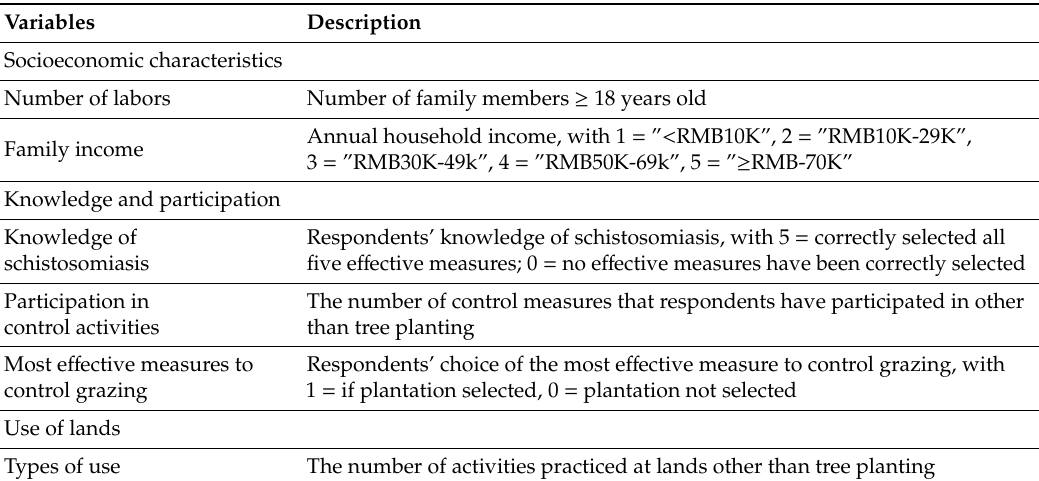
Table 2. Description of explanatory variables used in the generalized linear mixed model (GLMM)